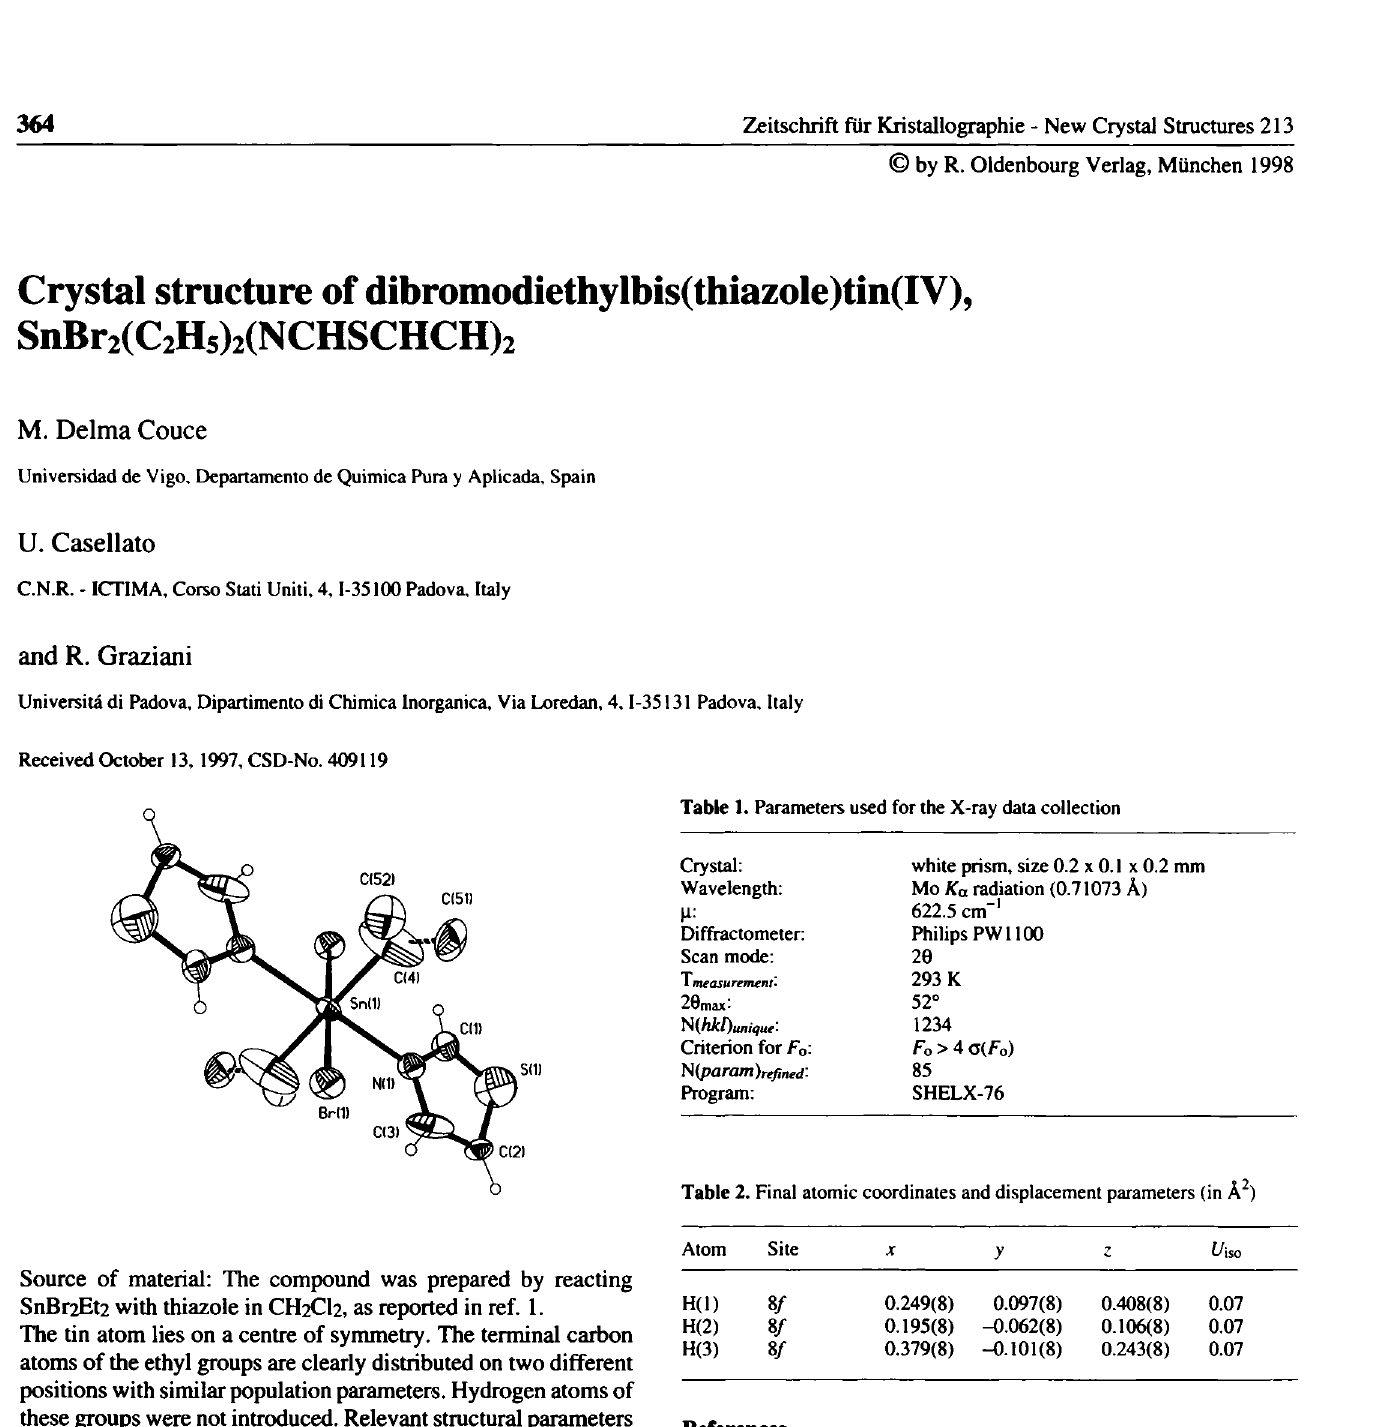
Table 2. Final atomic coordinates and displacement parameters (in